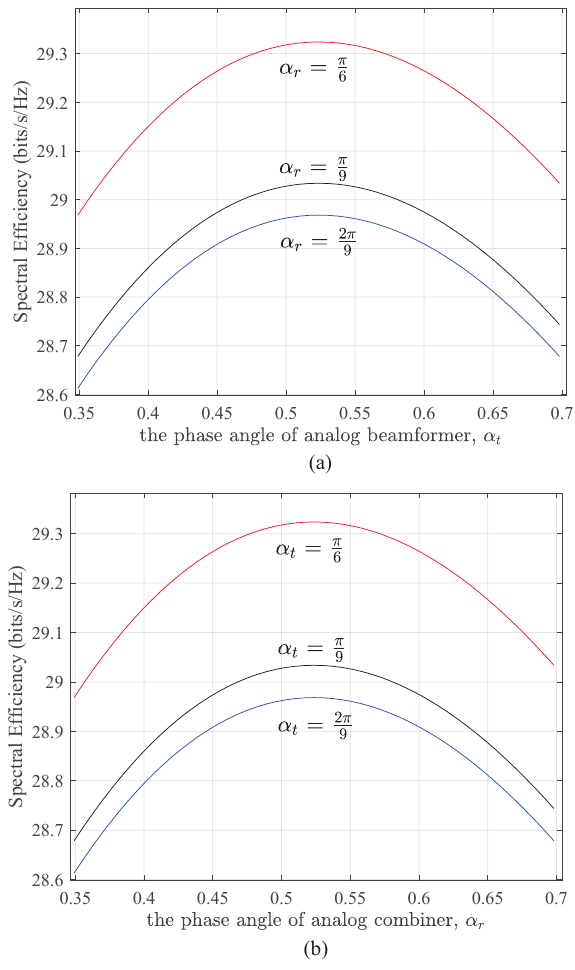
Figure 9. The relationship between spectral efficiency and phase angles of analog beamformer ( a ) and combiner ( b ),